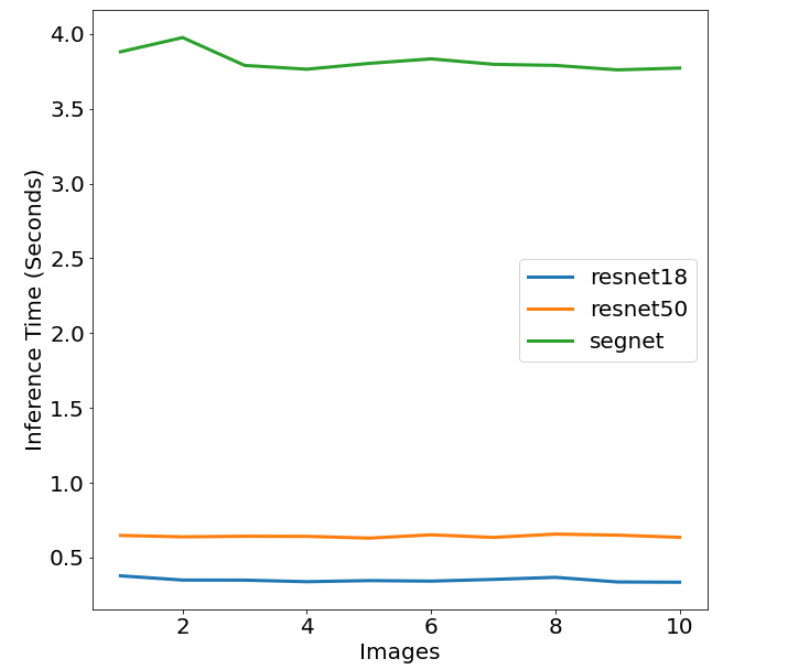
Figure 17. Inference time analysis of the trained